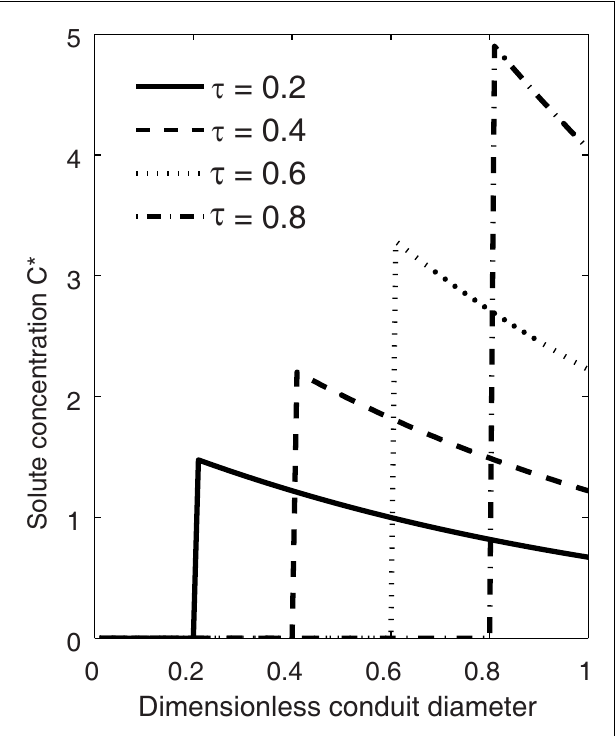
FIGURE 1 | Solute concentration ( C ∗ ) in a conduit during freezing presented in a stationary coordinate system (coordinate system immobilization transformation where the location of the origin of Eq. 16 is at v τ , and v fulfills x / τ = 1). At time τ = 0.2 the ice-water interface is at the location 0.2, and at time τ = 1 the whole conduit is frozen.The concentrations were calculated using Eq. 16.The Peclet number Pe = 1 (Eq. 12) and solute solubility in ice/solubility in water, C S =